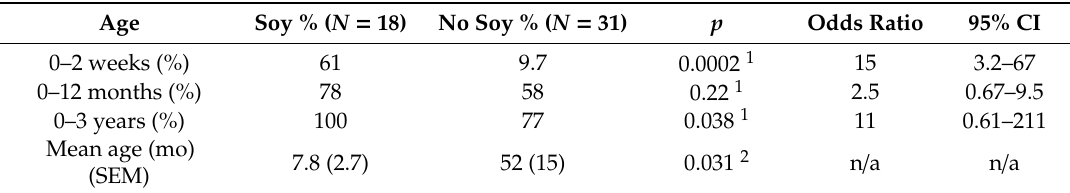
Table 9. Timeframe of GI problems in FXS study population as a function of soy-based